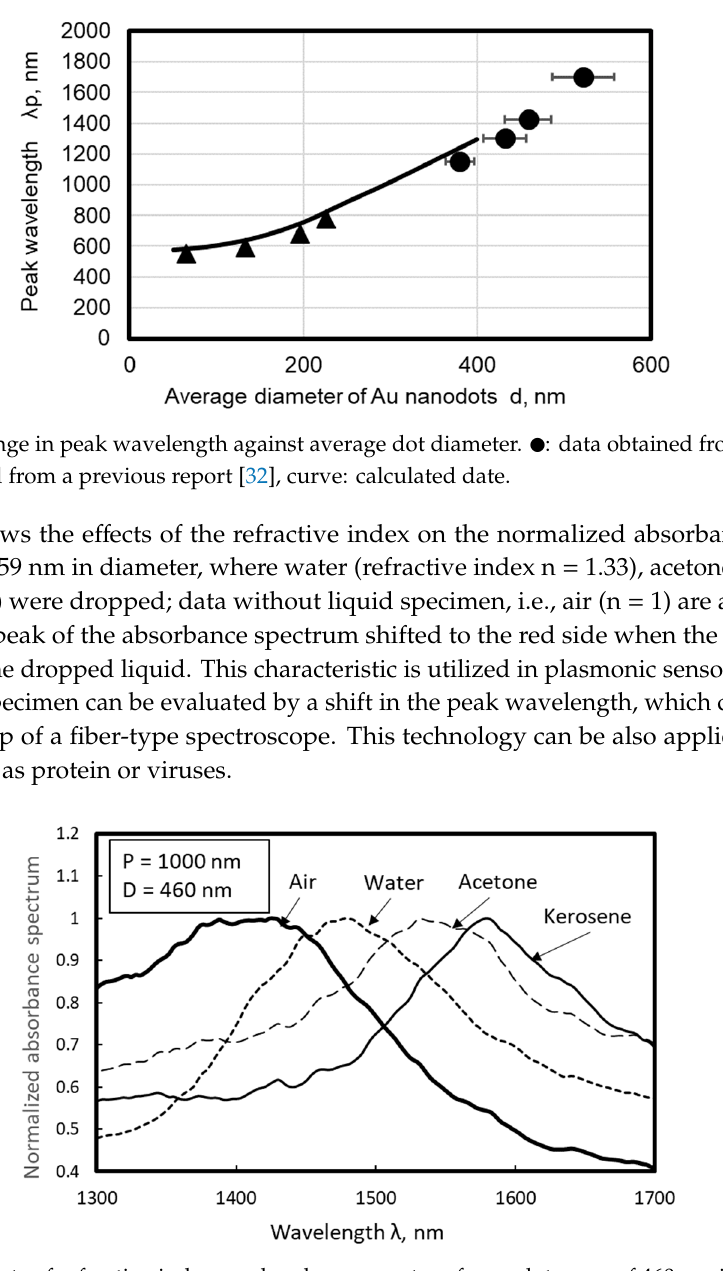
Figure 12. Effects of refractive index on absorbance spectra of nanodot array of 460 nm in diameter.